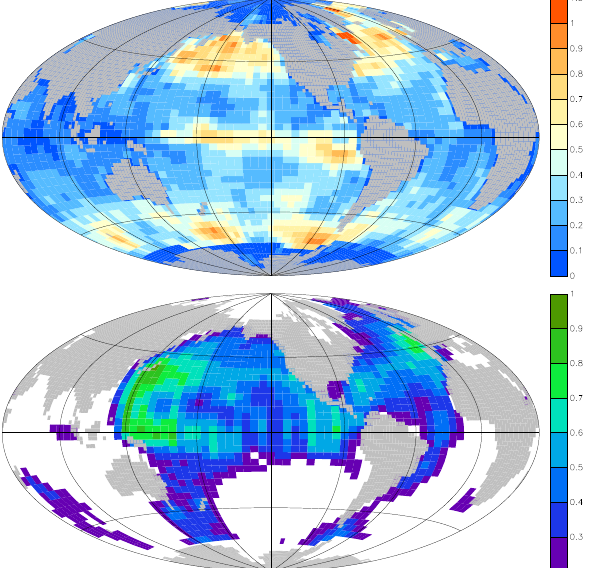
Fig. 2. Information flow between carbon and oxygen variables. Left: Inverse procedure of run SFC as in Fig. 1, estimating ocean- internal DIC sources/sinks from p CO 2 m data. Middle: Prediction of the oxygen sea–air flux: Ocean-internal oxygen sources/sinks are calculated from DIC sources/sinks via tracer-tracer coupling (TT) assumed to follow Redfield stoichiometries. Dissolved oxygen con- centration ( C O 2 m ) and sea–air oxygen flux ( f O 2 ma ) are then obtained Figure 4. Top: amplitude of IAV of the sea–air CO 2 flux es- from parameterizations of a mixed-layer oxygen budget (OB), as timated from SOCAT data (run SFC ), calculated as temporal Fig. 4. Top: Amplitude of IAV of the sea–air CO 2 flux es- well as oxygen solubility and sea–air gas exchange (GE), analo- standard deviation (1993–2008) of the interannually filtered flux timated from SOCAT data (run SFC ), calculated as temporal gous to those for carbon. Right: APO inversion of R¨odenbeck et al. (µmolm − 2 yr − 1 ). Bottom: capacity of the diagnostic scheme to re- standard deviation (1993–2008) of the interannually filtered flux (2008): Sea–air APO fluxes are estimated from APO observations trieve interannual variations in the sea–air CO 2 flux from SOCAT ( µ mol m − 2 yr − 1 ). Bottom: Capacity of the diagnostic scheme to (combined atmospheric oxygen and CO 2 data) by inversion of at- v2 data (reduction of uncertainty, average performance 1993–2008). retrieve interannual variations in the sea–air CO 2 flux from SOCAT mospheric transport (AT). Pixels with RoU < 0.2 have been left white. v2 data (Reduction of Uncertainty, average performance 1993– 2008). Pixels with RoU < 0 . 2 have been left uncolored.